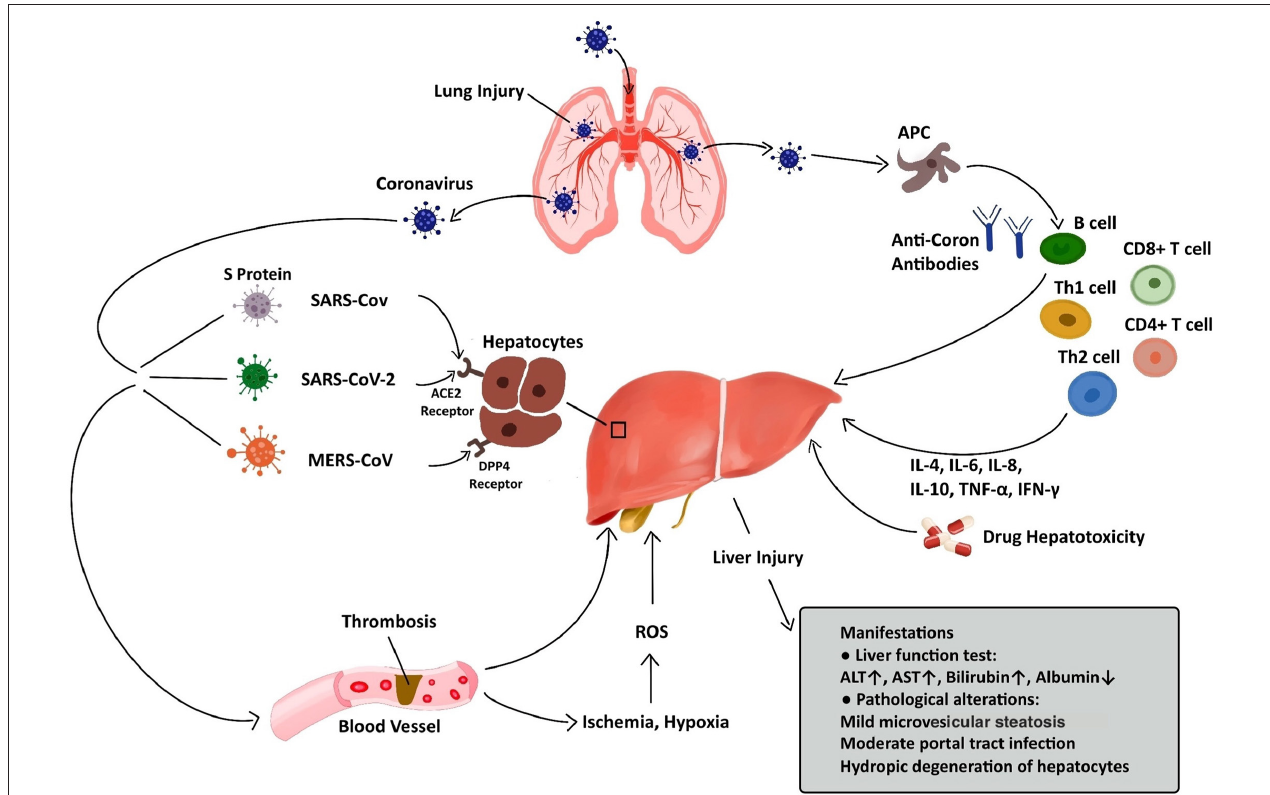
FIGURE 1 | Liver injury caused by coronavirus infection. After entry into the human body through the respiratory tract, coronaviruses can lead to liver injury via several approaches, including ACE2/DPP4-mediated hepatocyte injury, immune-mediated liver injury, ischemia and hypoxia, thrombosis, and drug hepatotoxicity. The manifestations of liver injury involve abnormalities in liver function test and pathological